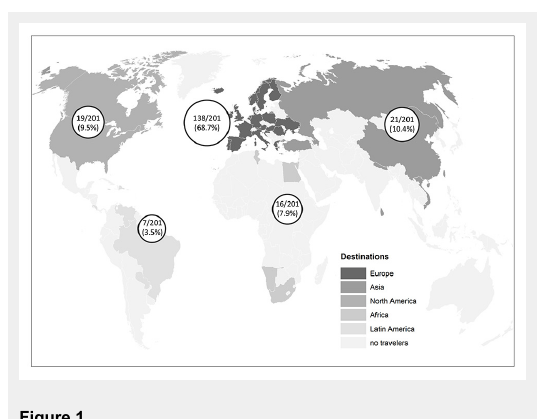
Distribution of reported travel destinations. In total 201 travel episodes were